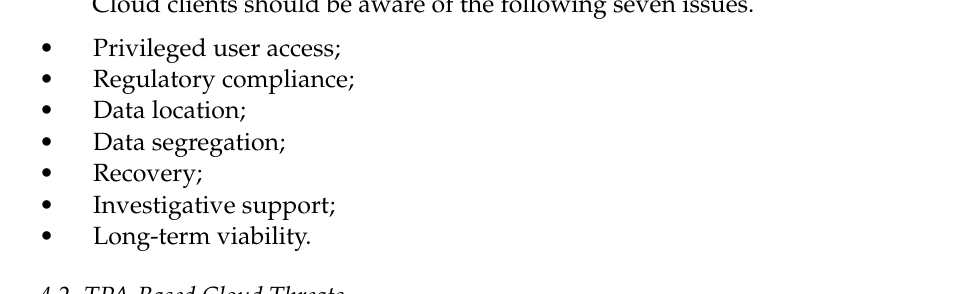
Figure 3. Evaluation and authentication of the client through